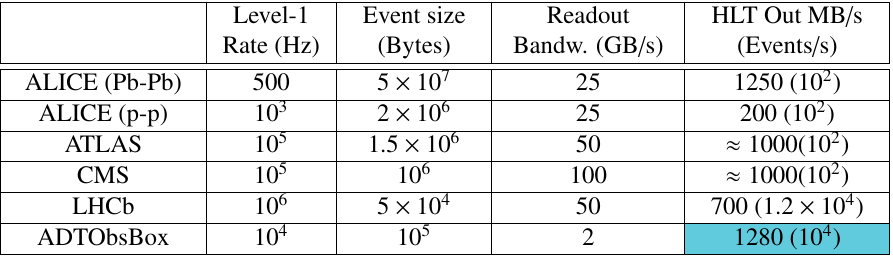
Table 1. Comparison of data generated by the ADTObsBox and the experiments at CERN